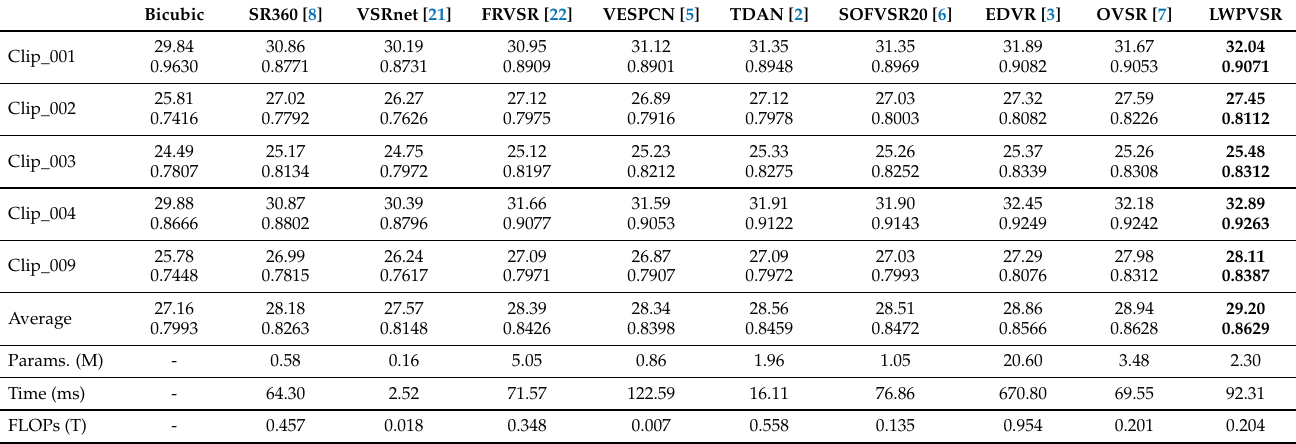
Table 4. Comparison of all the methods in terms of WS-PSNR and WS-SSIM on other video